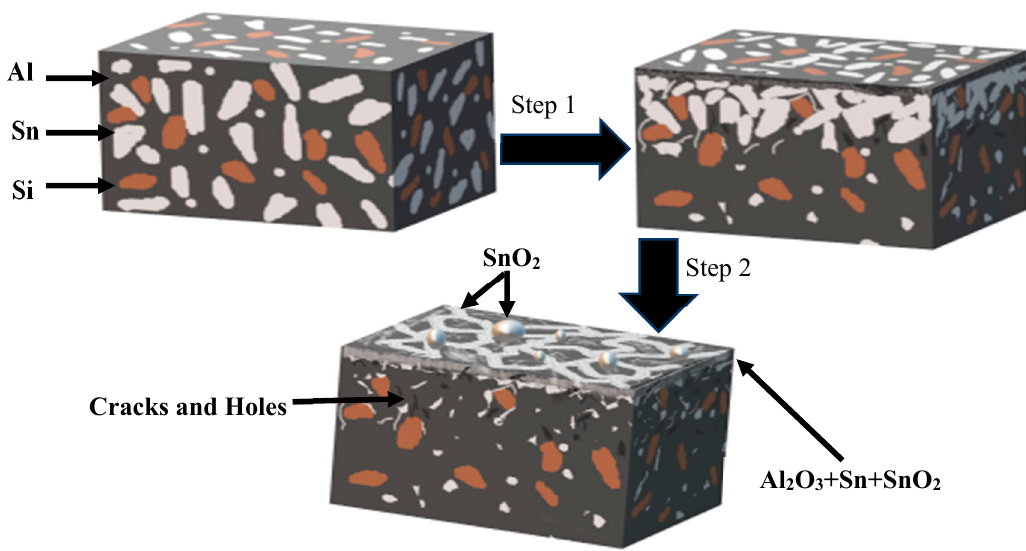
Figure 10. Oxidation mechanism picture of the Al-Sn bearing alloy.